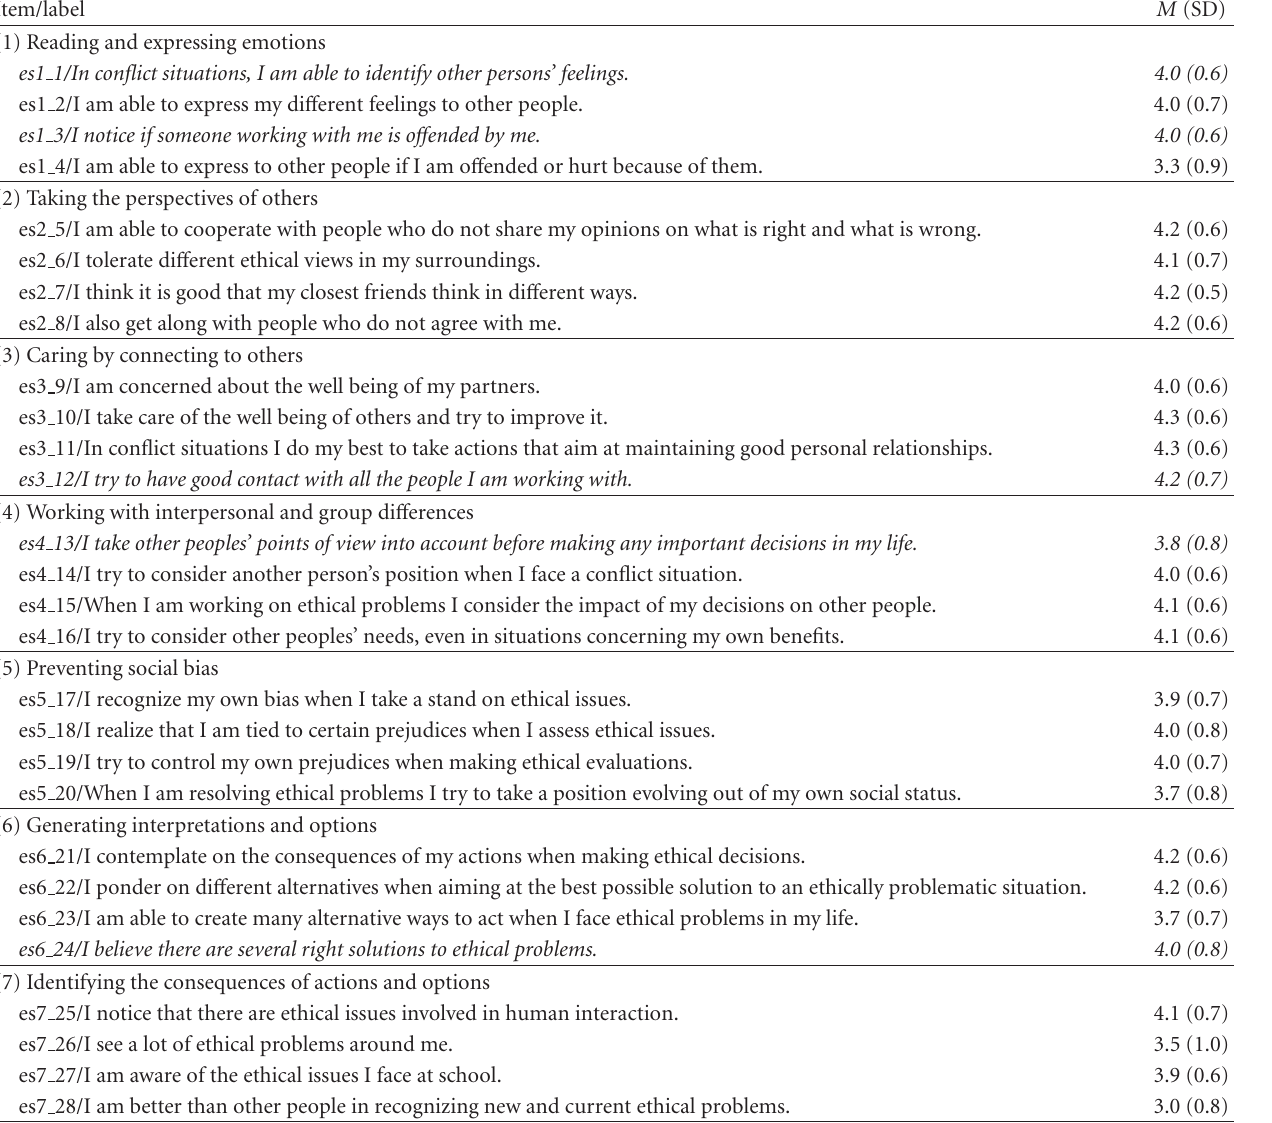
Table 1: The Ethical Sensitivity Scale Questionnaire